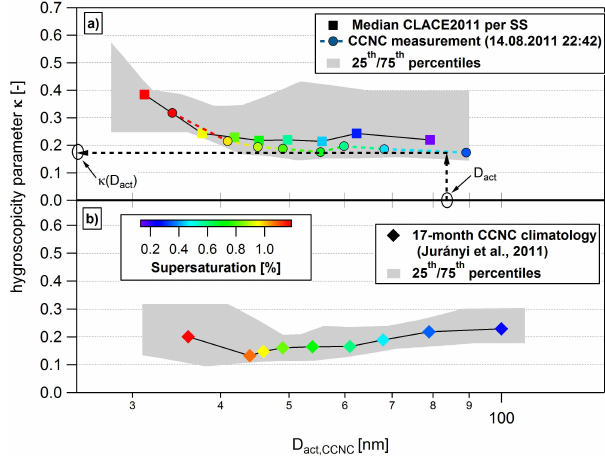
Fig. 4. Example of calculated critical dry diameter ( D act,CCNC ) and hygroscopicity parameter ( κ ) from the averaged CCNC measure- ments during CLACE2011 and a single, randomly picked example CCN spectrum measured by the CCNC at 8 different supersatura- tions on 14 August 2011 between 21:54 and 22:42 (a) . The 25th and 75th percentiles are indicated. In (b) the 17-month climatol- ogy of CCNC measurements is shown from Jurányi et al. (2011). The D act,CCNC has been calculated by integrating the particle num- ber size distribution (measured behind the total inlet) from its upper end down to D act . The diameter at which the integrated number concentration equals the measured CCN number concentration at the certain supersaturation (SS), corresponds to D act,CCNC ( SS set ) (see hatched area from Fig. 3c). The dashed arrows show how the κ value can be retrieved for a particular D act